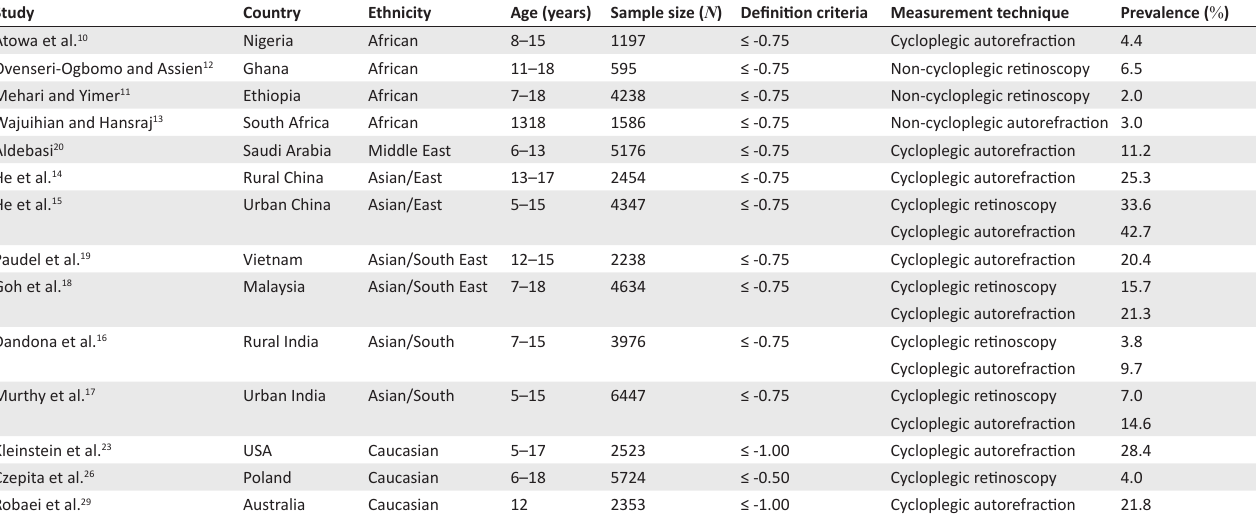
TABLE 3: Prevalence of astigmatism among school-age children in selected countries from various geographic regions. Study Country Age (years) Sample size ( N ) Definition criteria Measurement technique Atowa et al. 10